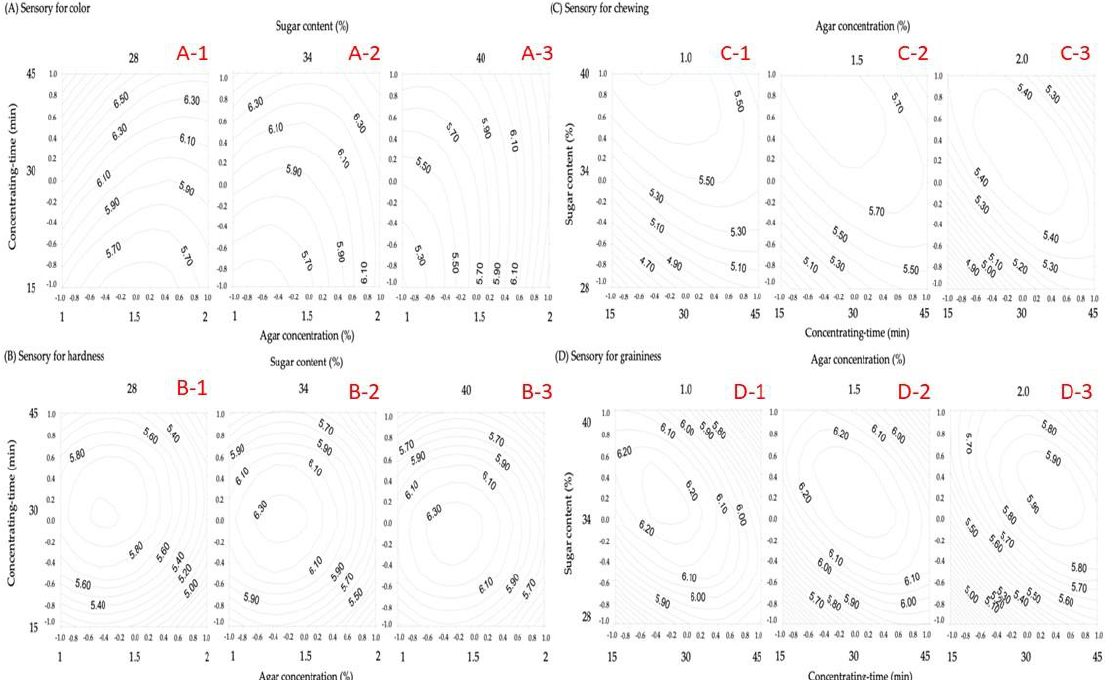
Figure 4. Contour plot of the processing conditions for the gelatinized adzuki-bean cake with respect to sensory evaluation of color, hardness, chewiness, and granularity.